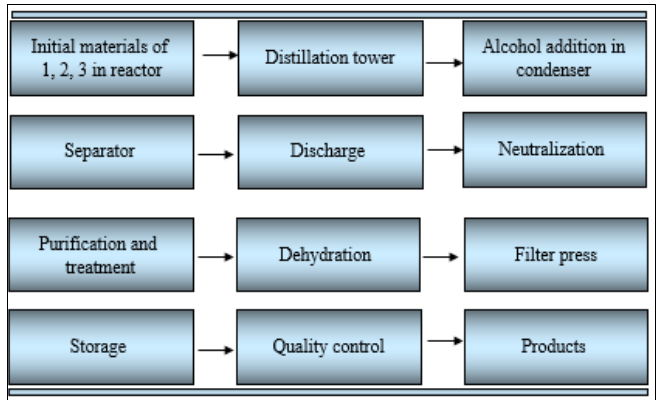
Figure 4: The steps of Phthalic anhydrous esters generation. Source: Author,